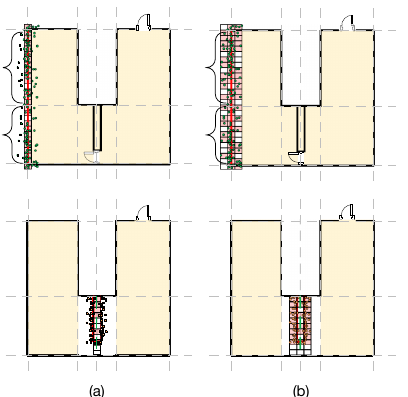
Figure 6. Different patterns of the weight definition. The dashed grey lines depict the result of the cell decomposition. a) 1 column grid map; b) 3 columns grid map.